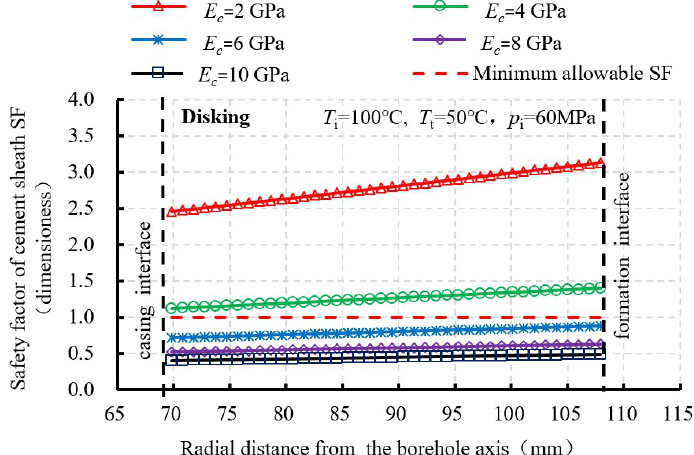
Figure 16. Radial distribution of the cement sheath safety factors for disking under a different elasticity modulus of cement sheath.